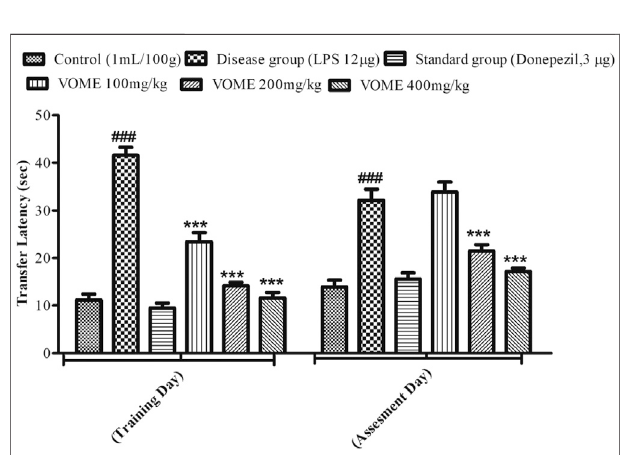
FIGURE 4 | Histogram presenting effect of Viola odorata methanolic extract on transfer latency (sec) in the elevated plus maze test in mice. Values are expressed as mean ± SEM , n (cid:1) 10 . ***p < 0.001 when compared with the LPS-treated group . ### p < 0.001 as compared to the control group.